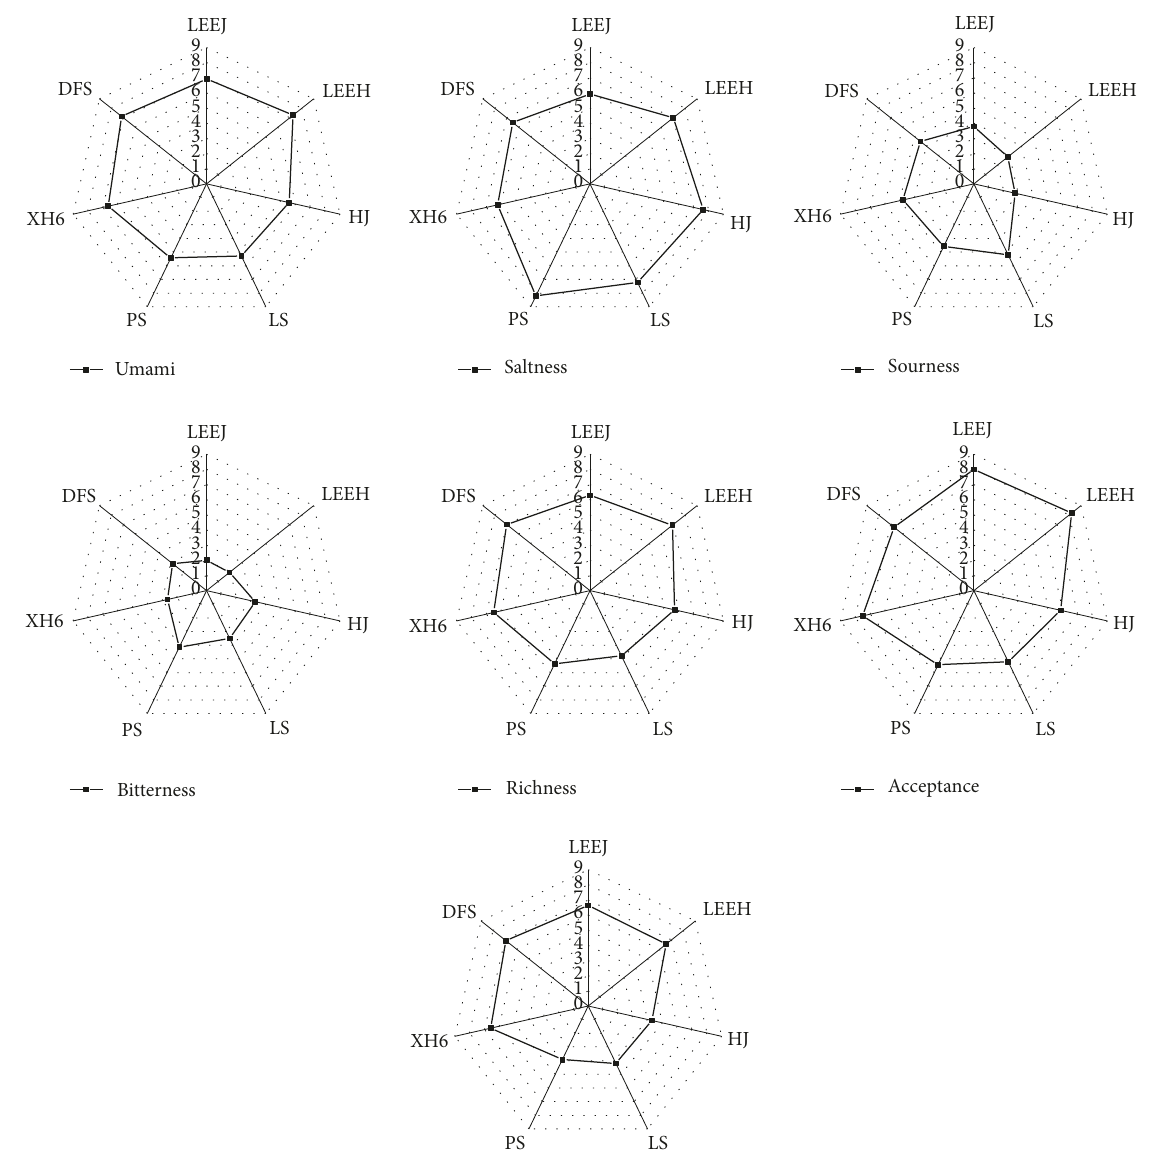
Figure 1: Radar plot of the SFFPs sensory descriptors, as assessed by trained panelists for each attribute. Sensory evaluation scores in the plot are means of triplicate analysis by 11